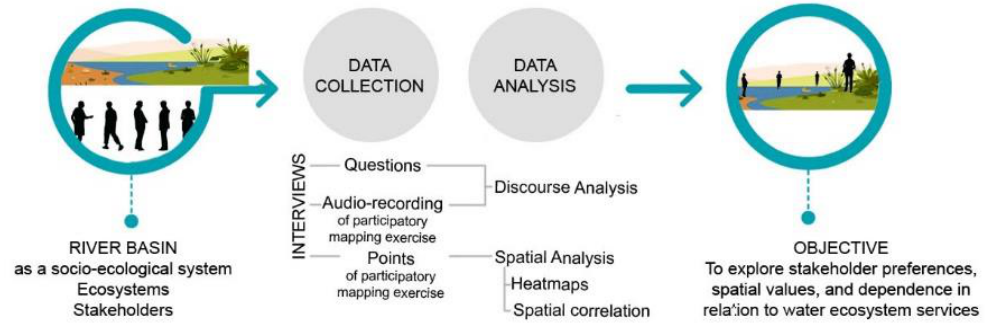
Figure 2. Methodological workflow.